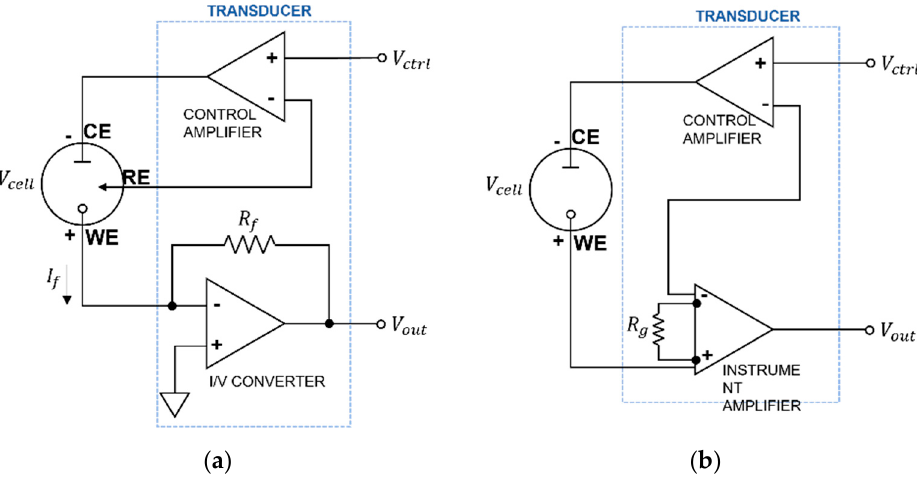
Figure 6. Left ( a ): a functional diagram of the transducer for amperometric biosensors. Right ( b ): a functional diagram for potentiometric biosensors.